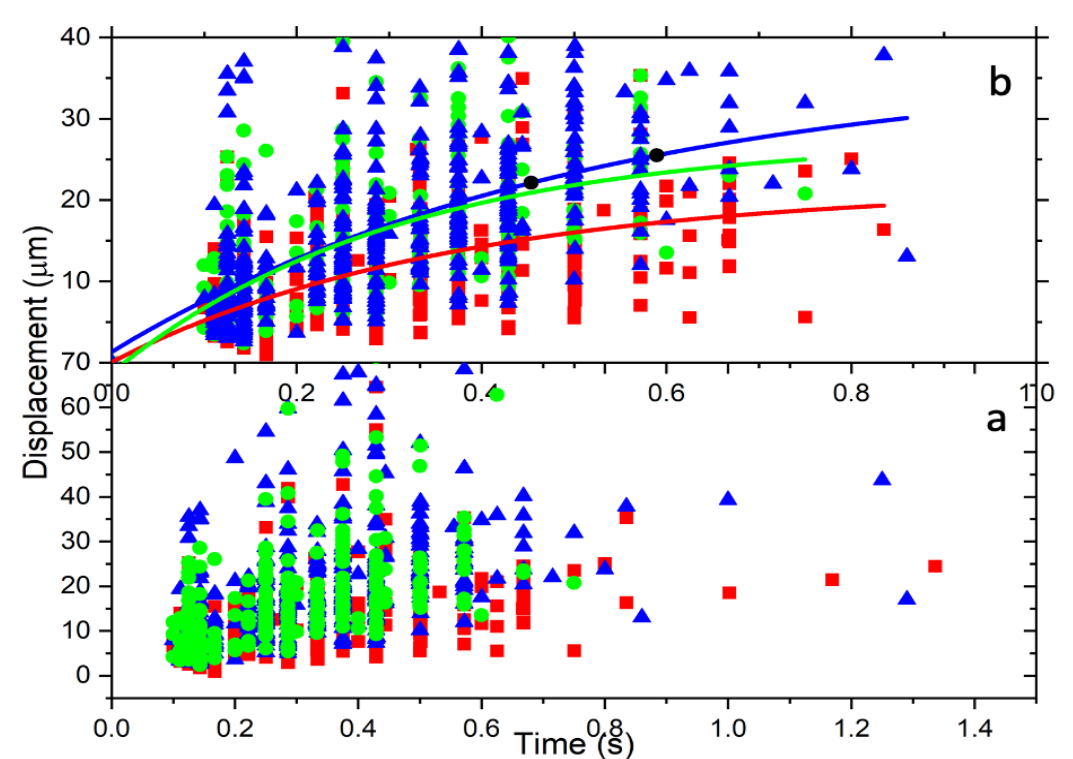
Figure 4. The radial displacement is a function of time. ( a ) All cells’ displacement over time and spread according to the cell’s mass. ( b ) These are reduced data resulting from the method described above. The data are fitted for a particular mass using Equation (31). The colors represent control (red), 2 h-treated (green), and 24 h-treated (blue).